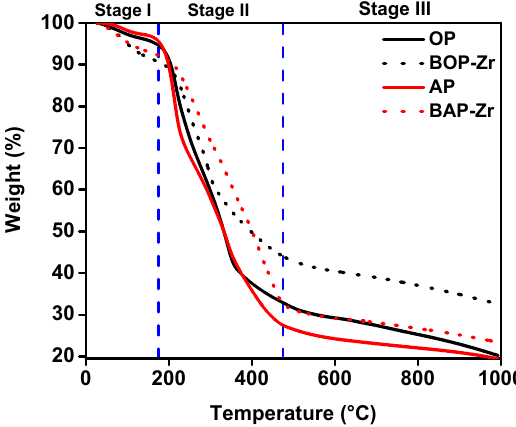
Figure 4. TGA curves of weight loss rate for OP (black line), BOP-Zr (black dashed-line), AP (red line), and BAP-Zr (red dashed-line) samples.